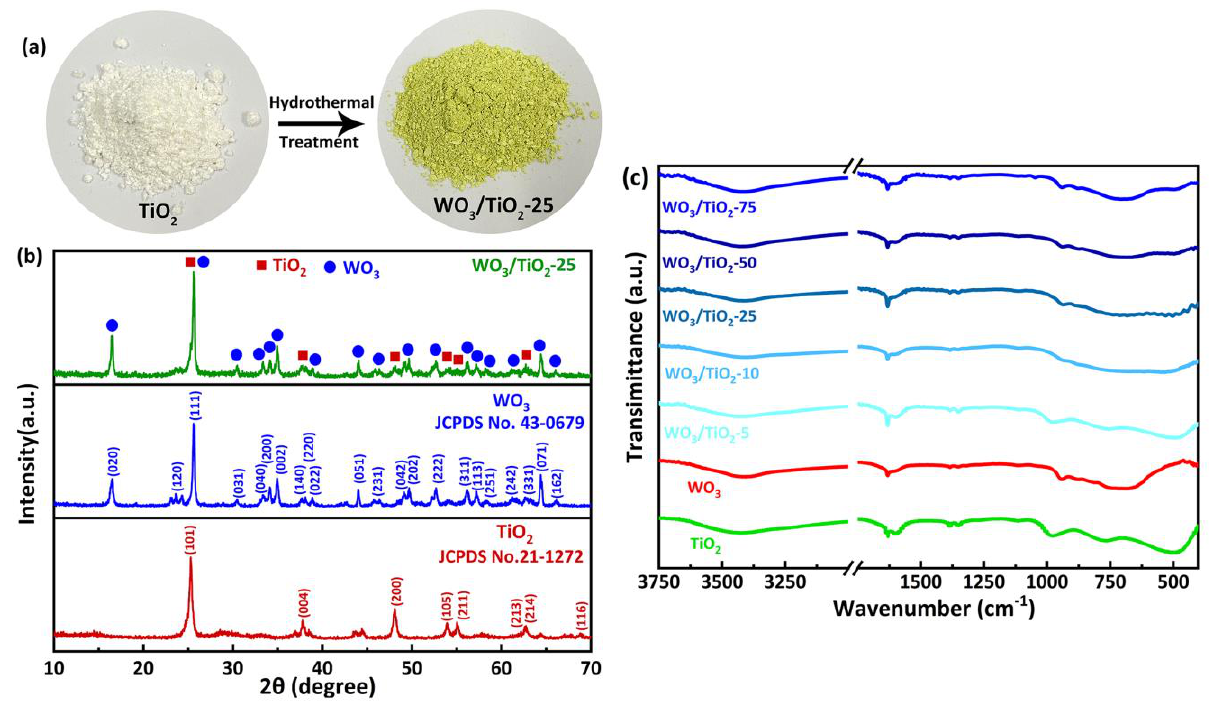
Figure 1. ( a ) Photograph of TiO 2 before and after hydrothermal growth of WO 3 . ( b ) XRD patterns of TiO 2 , WO 3 , and WO 3 /TiO 2 − 25. ( c ) FTIR spectra of TiO 2 , WO 3 , and WO 3 /TiO 2 composites with different ratios.